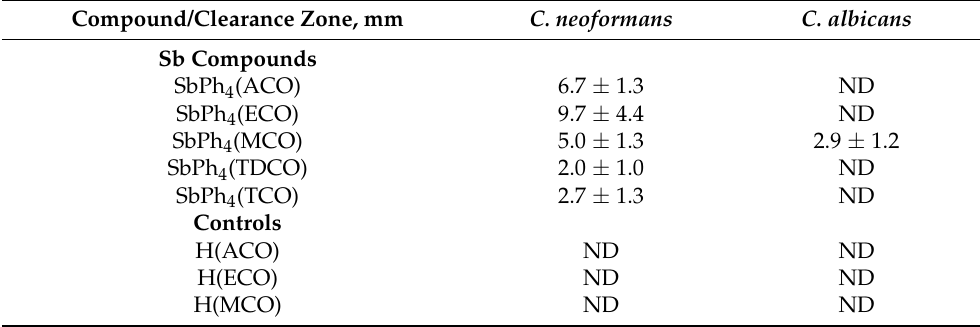
Table 2. Antifungal effect of new tetraphenyl-antimony(V) cyanoximates determined using a disc- diffusion assay. The zones of clearance (mm) surrounding the discs are reported as diameters averaged from three samples ± SEM. ND, no clearance zone